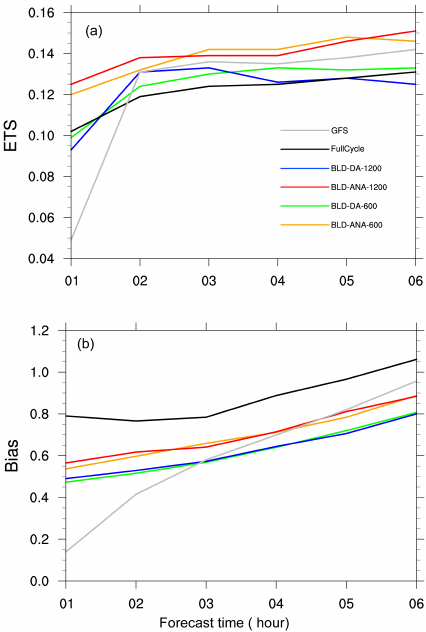
Figure 8. Averaged hourly accumulated precipitation forecast skill for the threshold 1mm (a) ETS and (b)